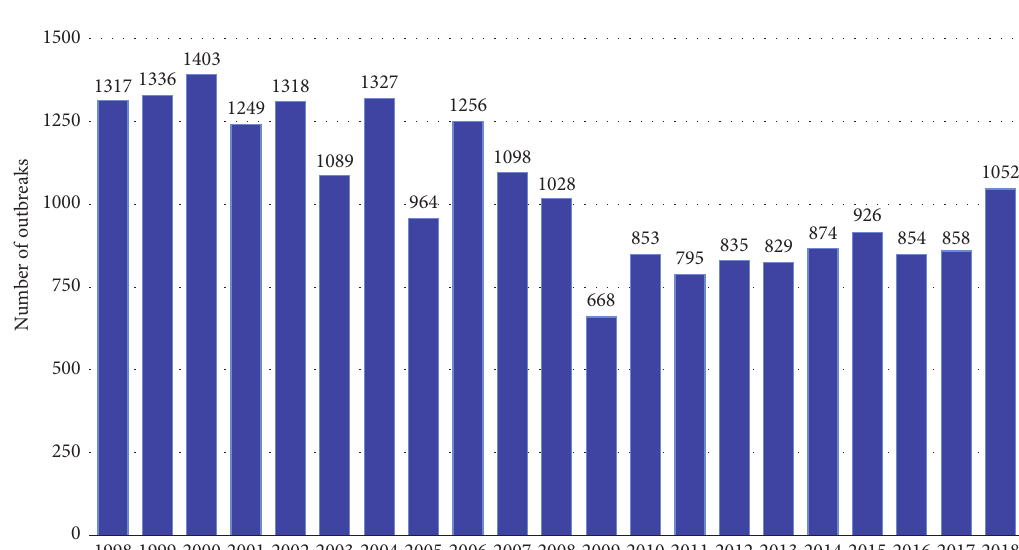
Figure 1: Food-related diseases rate in the USA